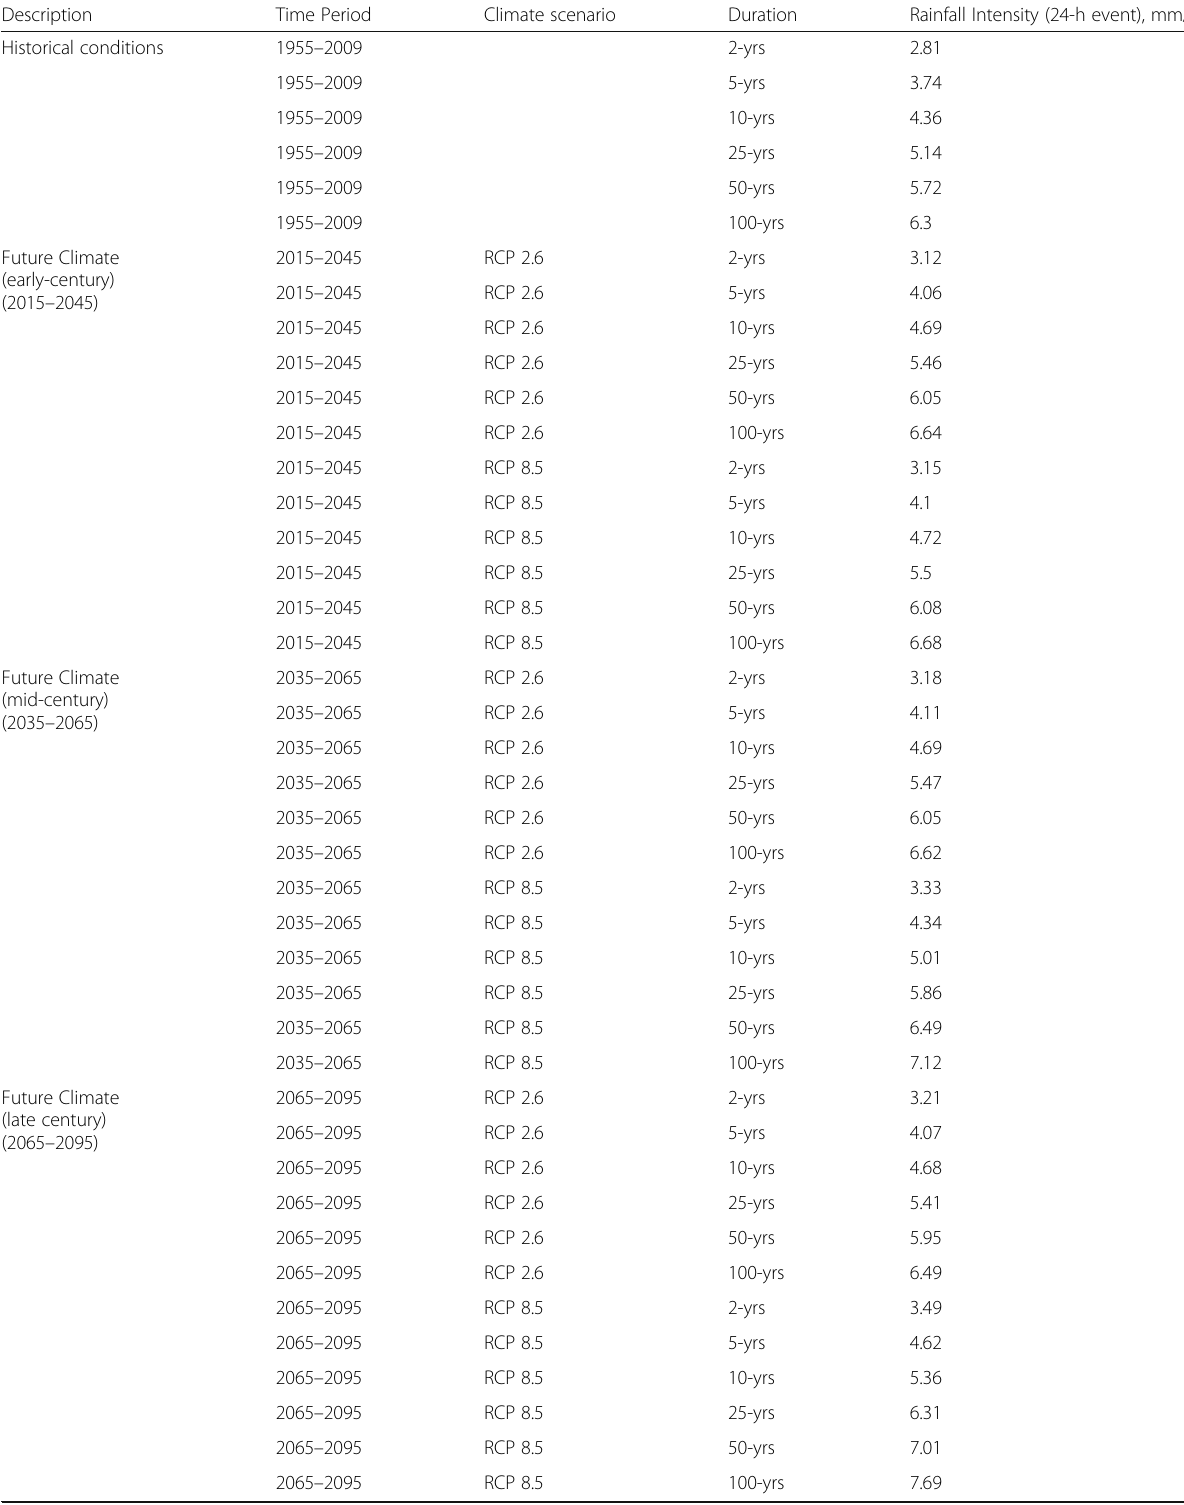
Table 1 Sample 24-h precipitation conditions used for adjusting the G-CAT®